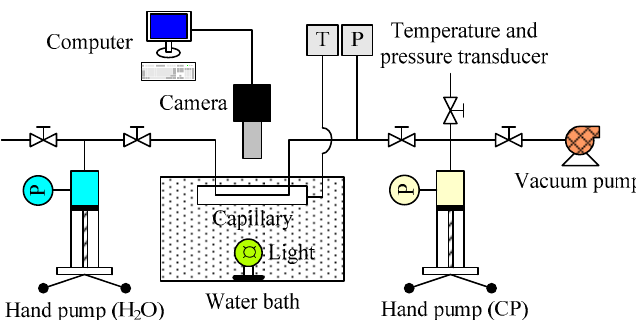
Figure 1. Schematic diagram of the experimental apparatus.